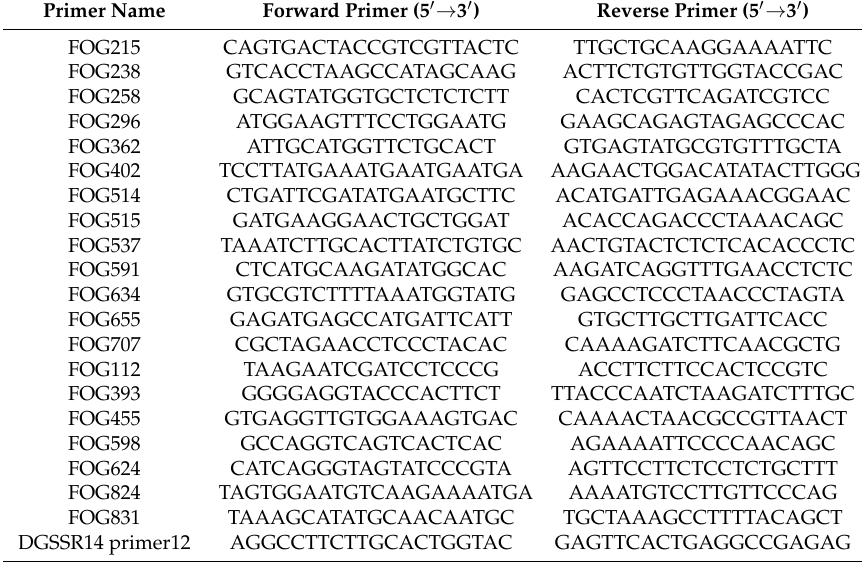
Table 6. SSR primer sequences.